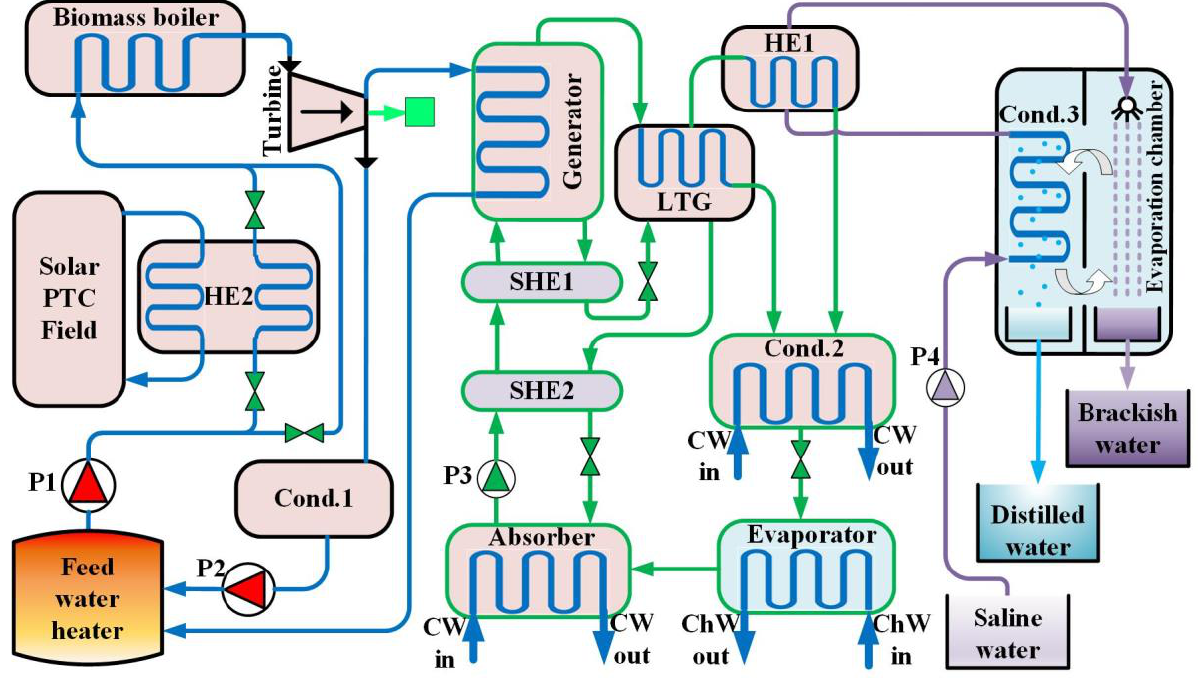
Figure 13. Schematic solar – biomass power with the desalination-cooling process (adapted from [116]).